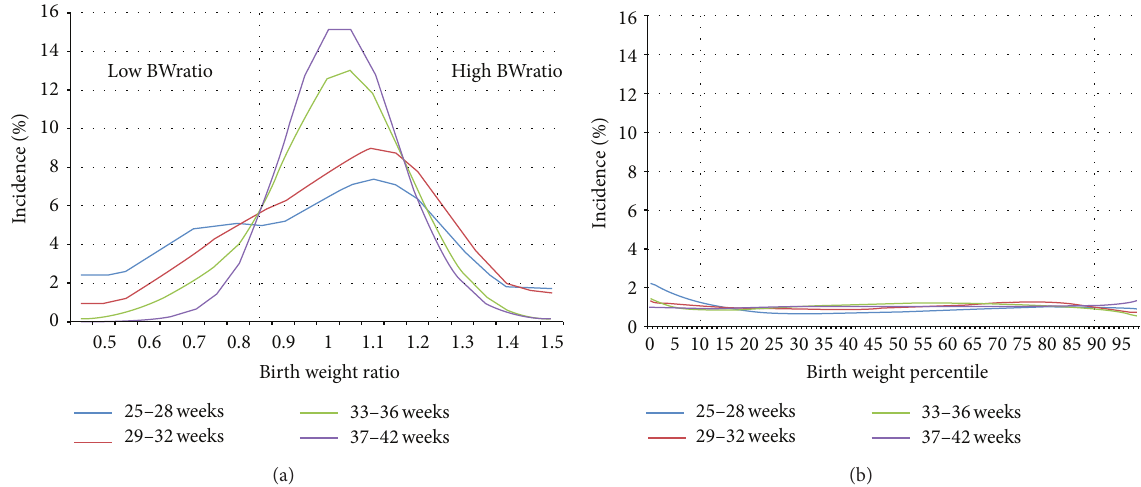
Figure 1: The incidence of birth weight ratios and birth weight percentiles for four strata of gestational age at birth separate for birth weight ratio (a) and birth weight percentiles (b).